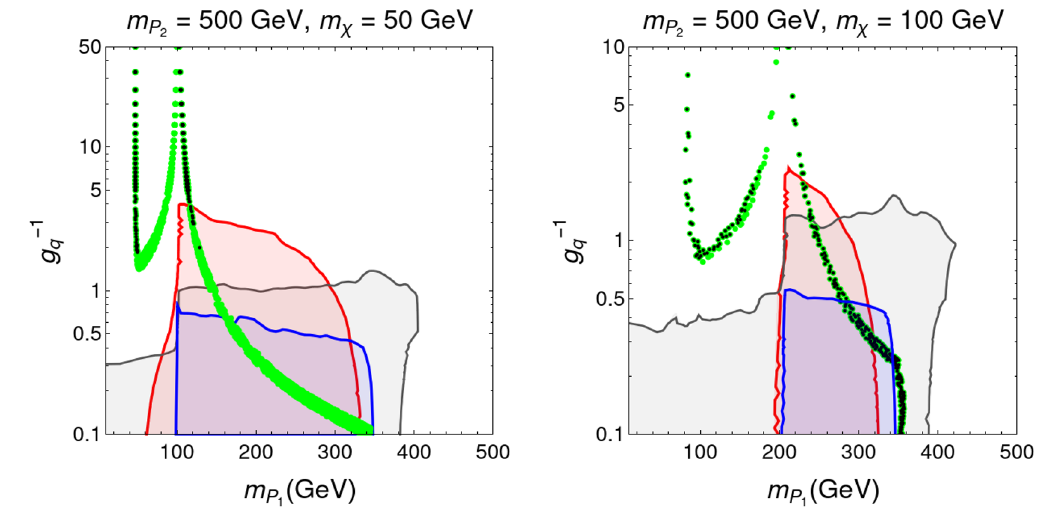
Figure 4 . Same as in figure 3, but for different mass setups in the two-mediator case. We consider = 500 GeV, together with m m P 2